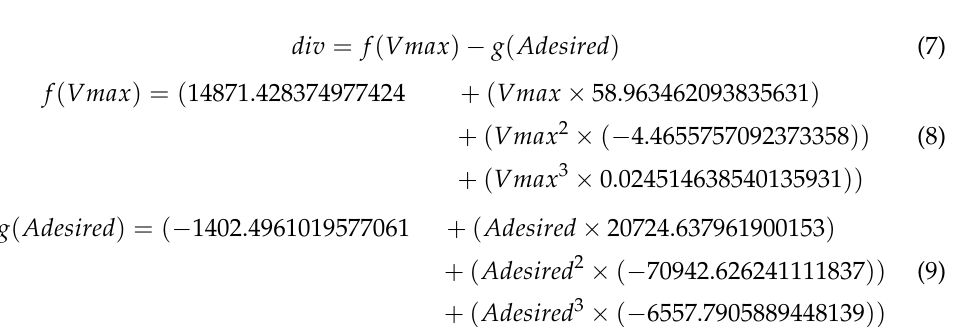
Figure 7. PID++ Adesired